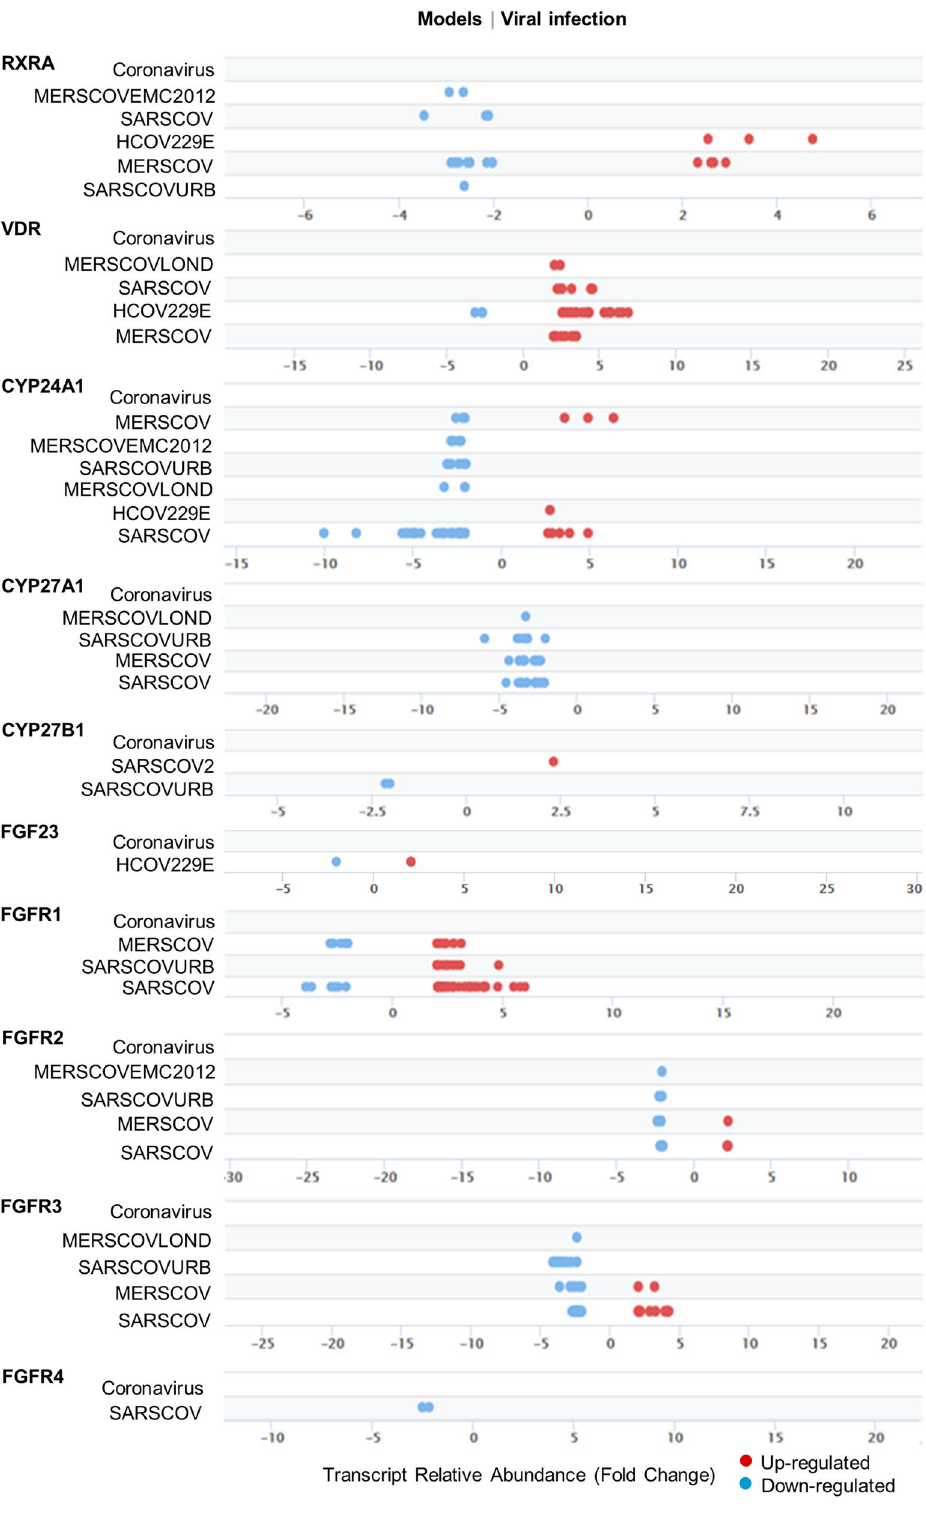
Figure 1. Outlook of Vitamin D components in viral infection models. Expression and distribution of individual genes in Vitamin D component with FDR 5E−02 from vitamin D components under various viral infection models from Signaling Pathway